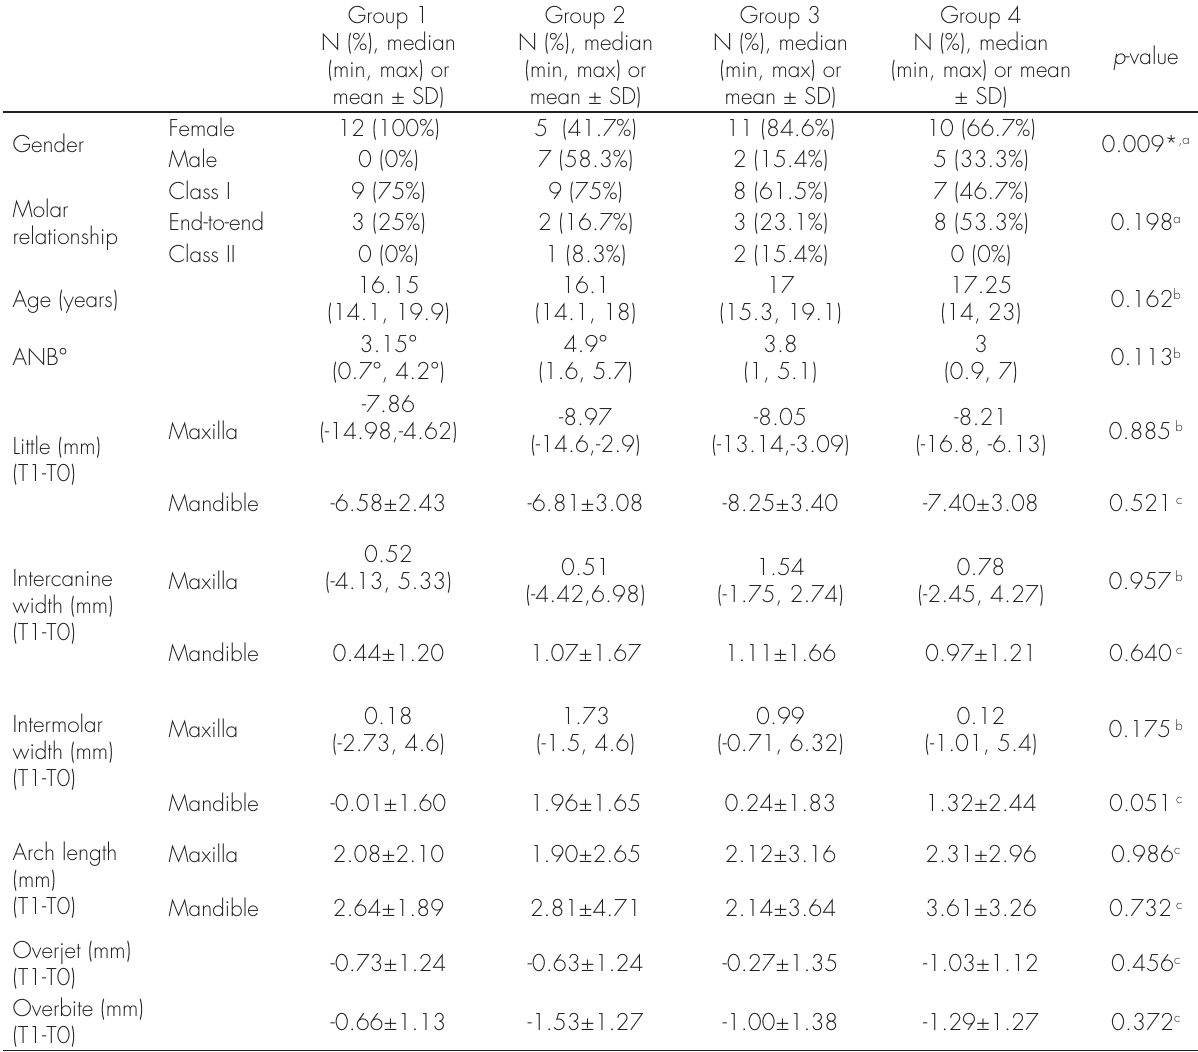
Table I. Comparisons of gender and age at debonding, molar relationships and ANB ̊ before orthodontic treatment, and changes in arch dimensions with active orthodontic treatment between the